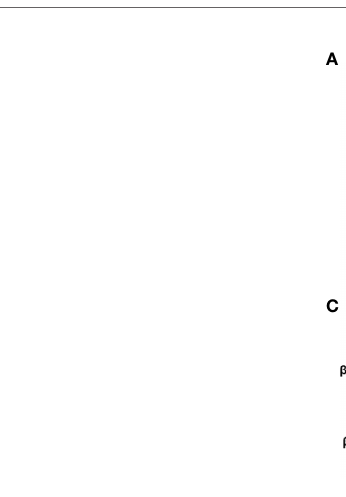
FIGURE 5 | miR-199a regulates MeCP2-TRPC3 expression. (A) The expression of Trpc3 was detected by real-time PCR. n=10. (B) The expression of SFRP4 was detected by real-time PCR. n=10. (C, D) Western blot experiments to detect the expression levels of Trpc3 and SFRP4 in JEG3 cells transfected with miR-199a mimics. n=3, * P <0.05, ** P